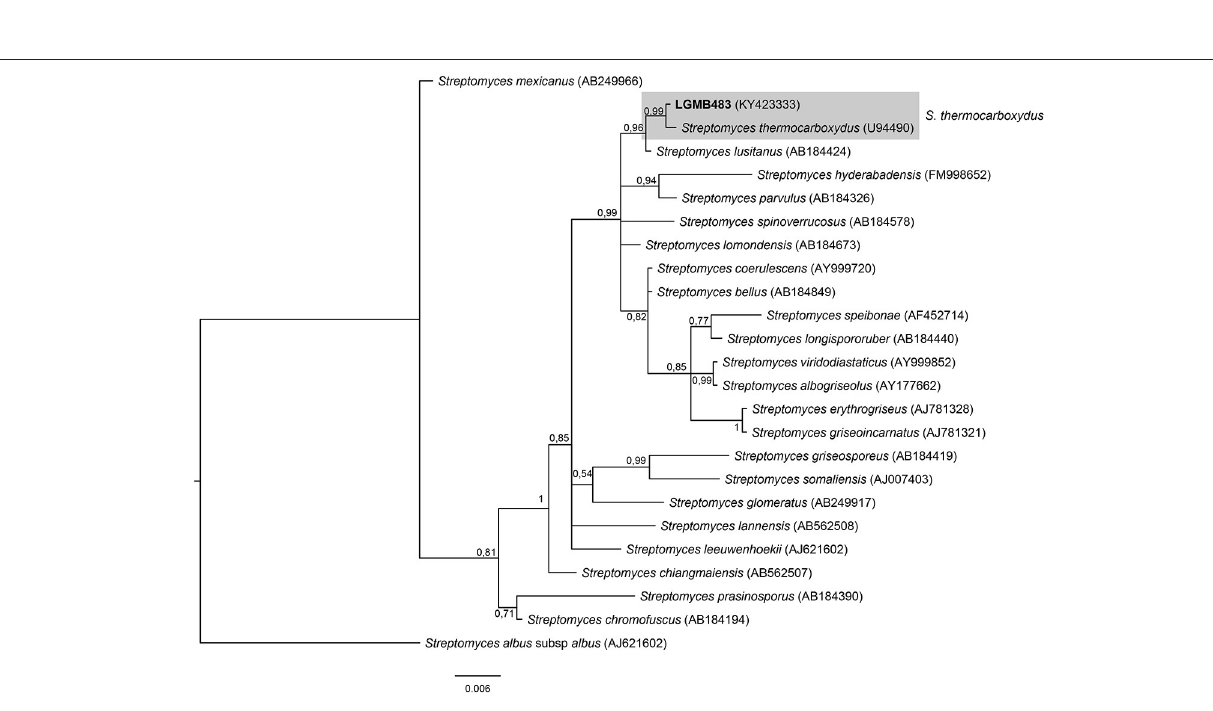
Frontiers in Microbiology | www.frontiersin.org